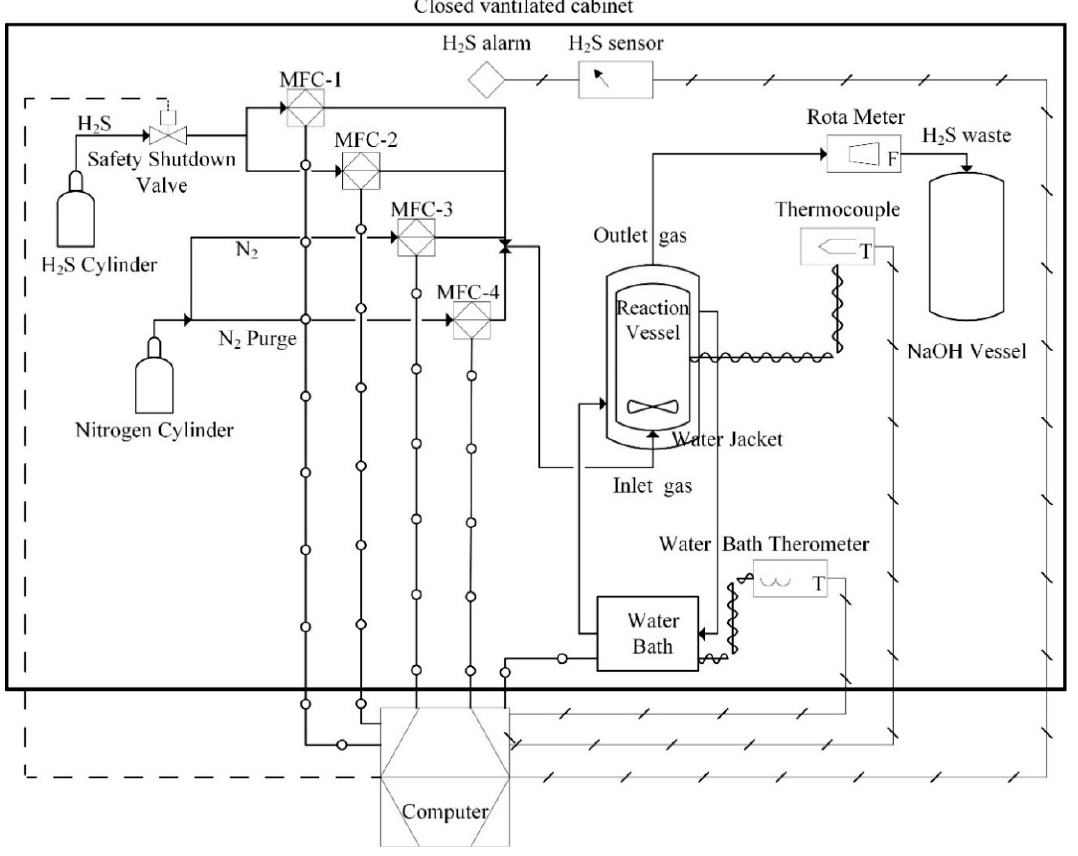
Figure 2. Schematic flow diagram of the screening apparatus.